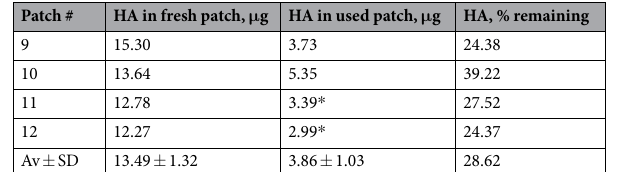
Table 1. Delivery efficiency of FG patches. * Slightly below lowest STDEV.